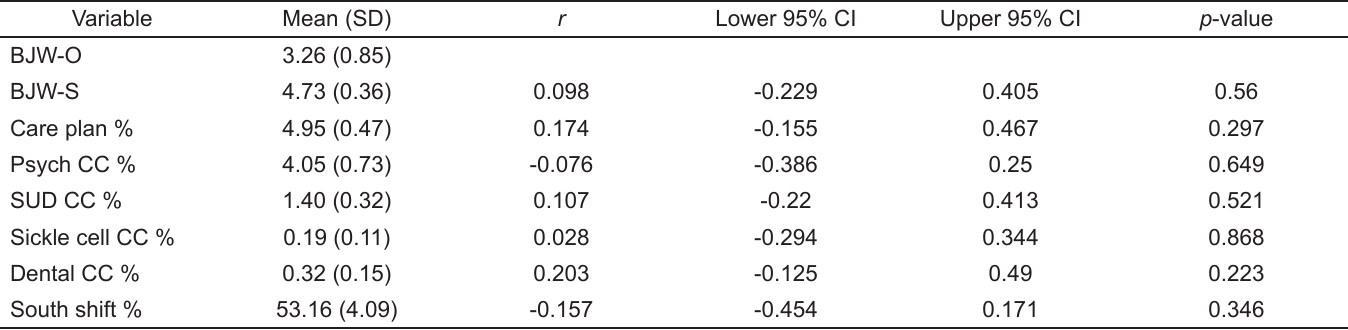
Table 2. Correlations (Pearson’s r) of “belief in a just world for others” scores with belief in a just world for self and the percentage of patients seen with a care plan, psychiatric, substance use disorder, and sickle cell or dental pain chief complaints.